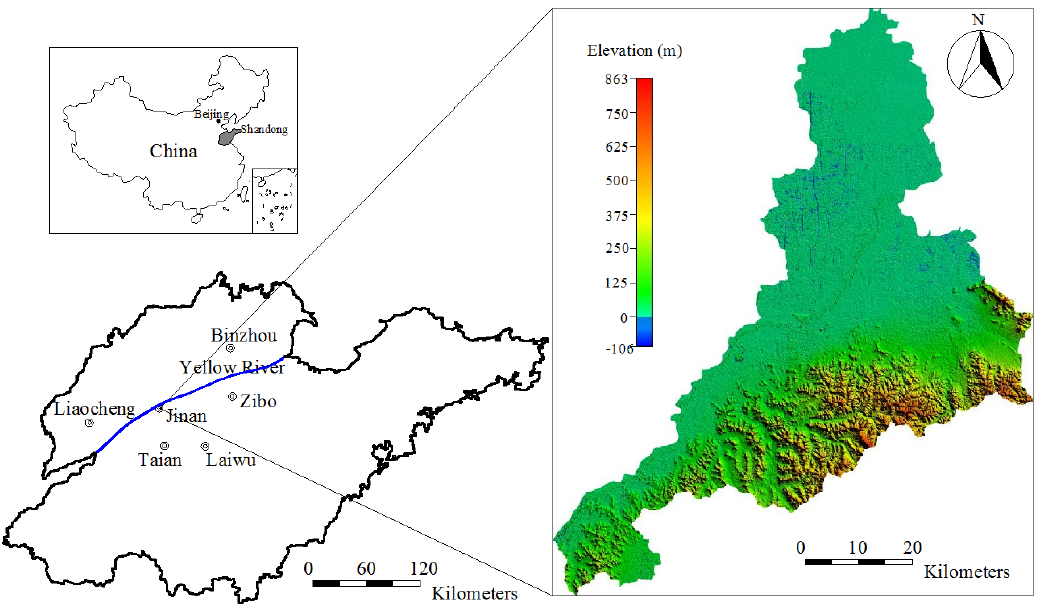
Figure 1. The study area in Jinan city, Shandong, China.